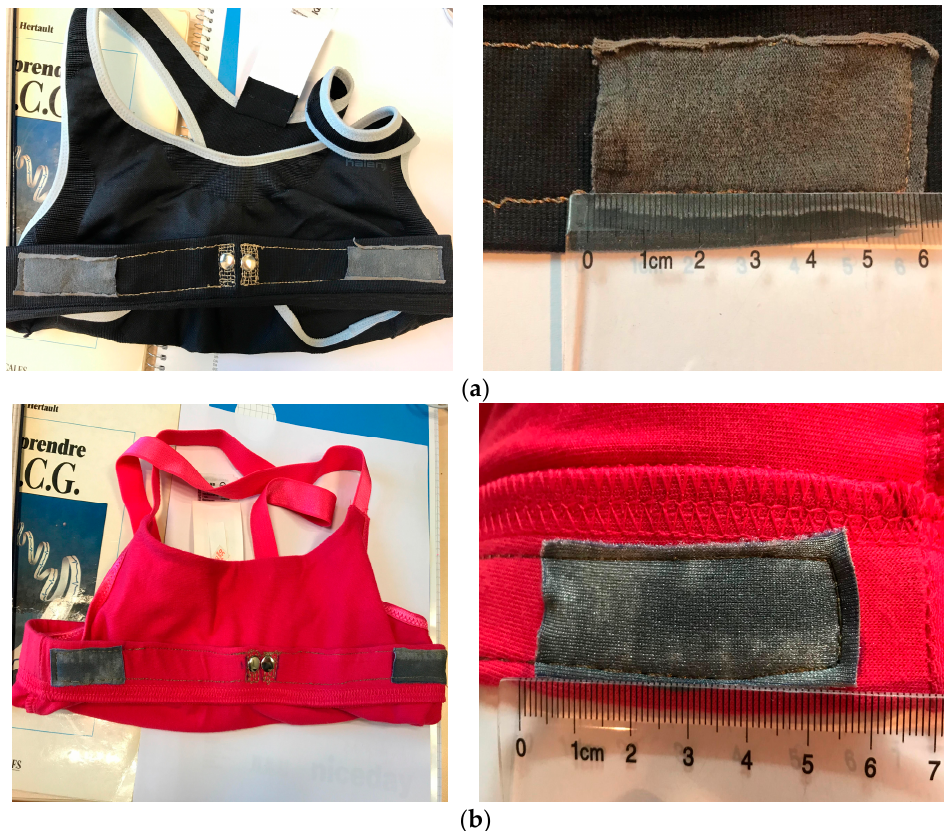
Figure 3. Schematic representation of a normal electrocardiogram (ECG). P, Q, R, S, T are graphical deflections of a typical electrocardiogram. They express depolarization and repolarization of the human heart.